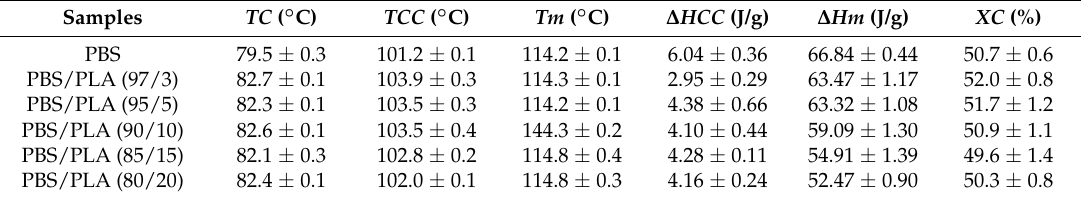
Figure 8. DSC curves of the neat PBS, PLA and the cold-drawn PBS/PLA composites with various PLA concentrations: ( A ) first cooling curves and ( B ) second heating curves. Table 2. DSC parameters of PBS phase in neat PBS, PLA and the cold-drawn PBS/PLA composites.